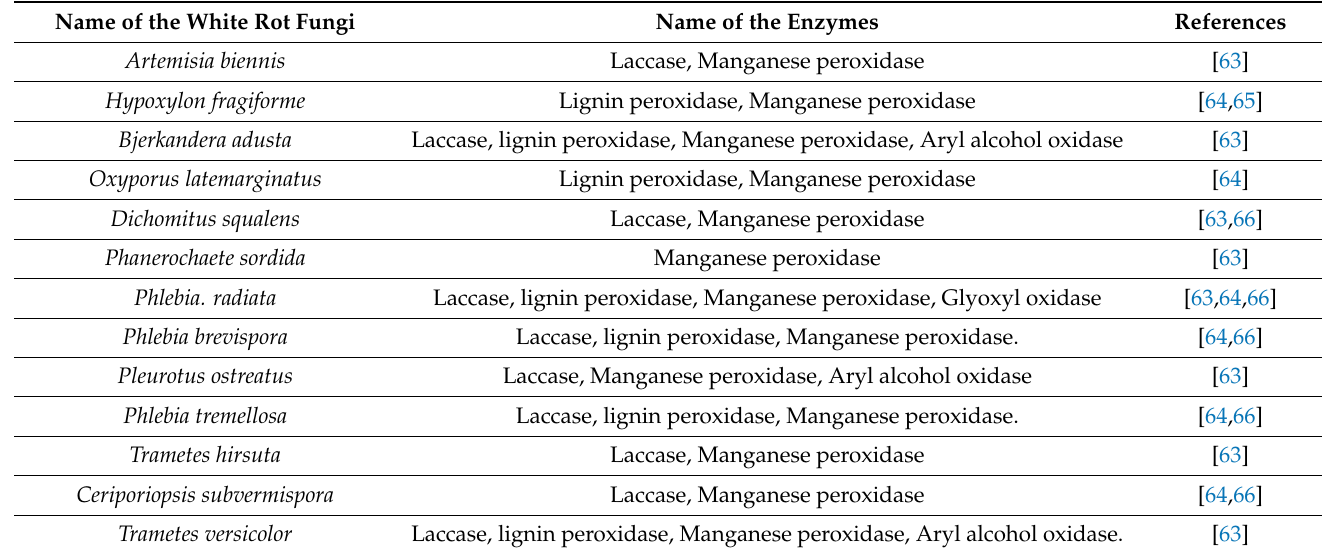
Table 4. Lignolytic Enzymes detected from white rot fungi.